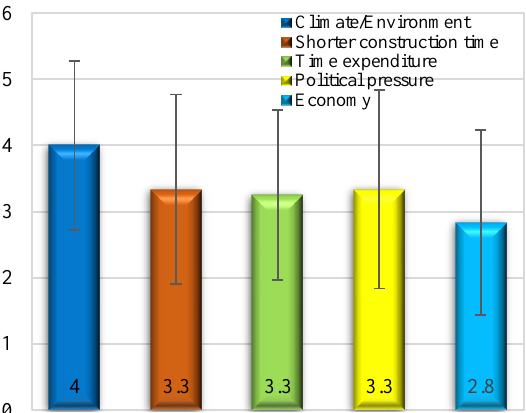
Figure 5. Ranking of influencing factors on decision of ERs to choose wooden frames.